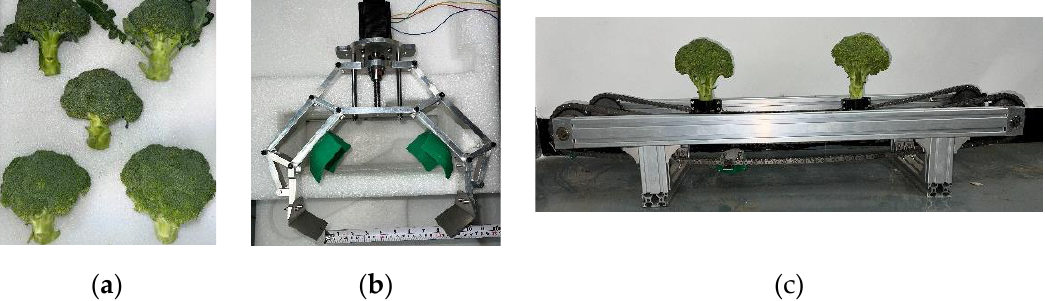
Figure 14. Test material: ( a ) Broccoli of different diameters; ( b ) Initial state of the manipulator; ( c ) Broccoli-picking location.